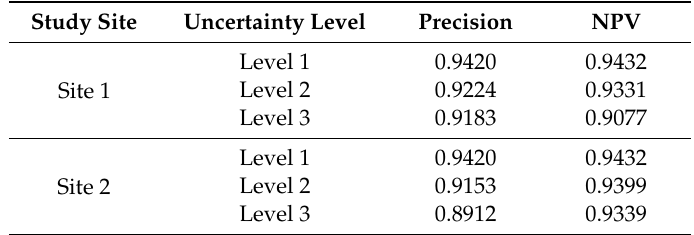
Table 3. Accuracy of the CD objects with different uncertainty levels.